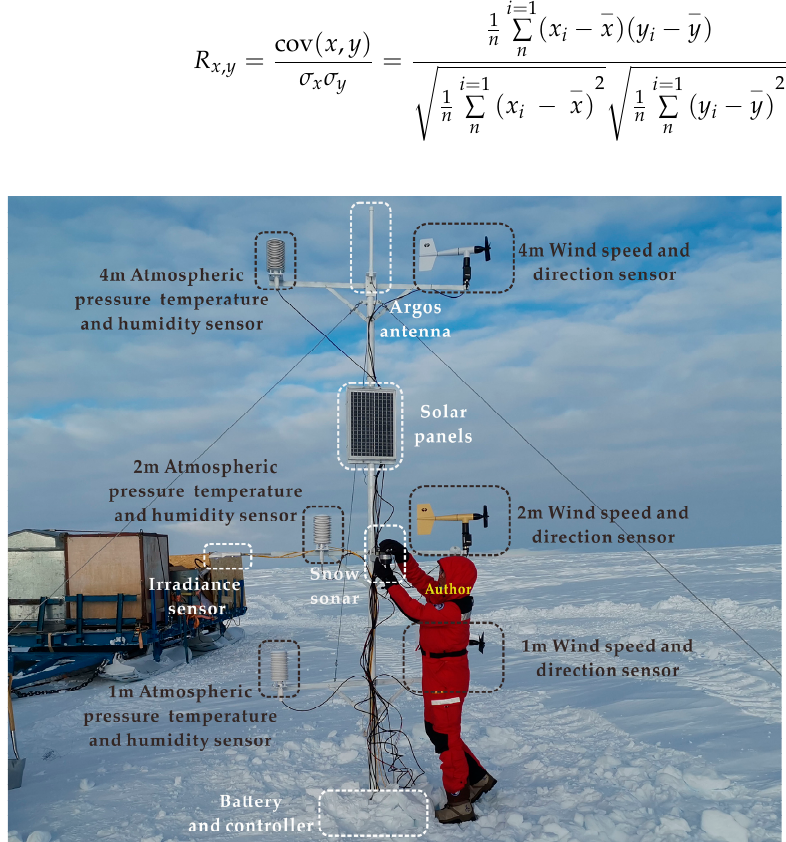
Figure 2. Photo of the author’s fieldwork during the installation of the Panda 300 weather station on the way to an inland scientific expedition on 13 December 2019.